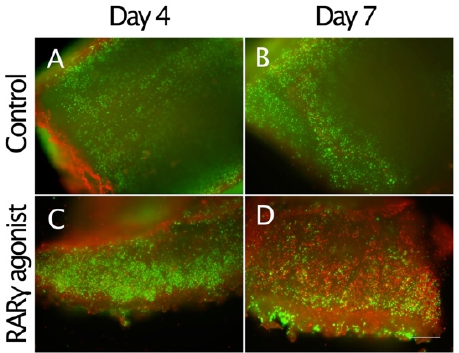
Figure 6. Stimulation of cell death by RAR γ agonists in osteochondroma explant cultures. The osteochondroma explants were treated with vehicle (0.1% ethanol) ( A and B ) or 300 nM NRX204647 ( C and D ) in DMEM containing 2% charcoal-treated FBS ( n = 2, 3 patients). The explants were subjected to Live/death assay 4 or 7 days after treatment. Note that a much larger number of cells incorporated red-fluorescent ethidium homodimer-1 in the RAR γ agonist-treated culture on day 7. Bars are 600 μ m for A – D .